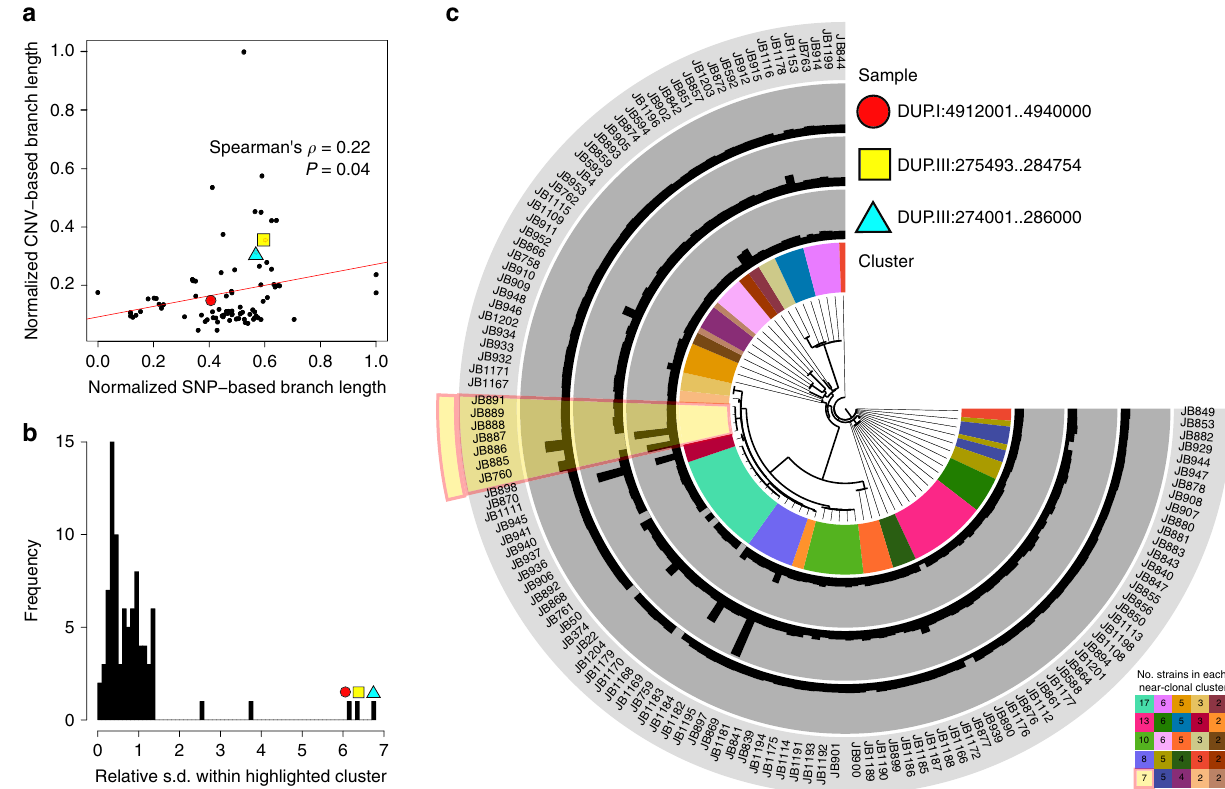
Figure 2 | CNVs are transient within fission yeast. ( a ) For each of the 87 CNVs we calculated the genetic distance between strains using SNPs in the region around the CNV (20kb up- and downstream of the CNV, merged) as the total branch length from an approximate maximum-likelihood tree ( x axis, SNP-based branch length normalized to maximum value). We further calculated a CNV-based distance using the total branch length from a neighbour-joining tree constructed from Euclidean distances between strains based on their copy numbers ( y axis, CNV-based branch length normalized to maximum value). The weak correlation indicates that CNVs are subject to additional or different evolutionary processes. ( b ) Histogram of the standard deviation of each CNV within a near-clonal cluster (see also Fig. 2a), relative to its standard deviation across strains not in the near-clonal cluster. Standard deviation is highly correlated with CNV-based branch length (Spearman rank correlation r ¼ 0.90, P o 0.001) (Supplementary Fig. 4b). The highlighted CNVs have unusually high rates of variation within this cluster compared with other clusters. ( c ) Copy number variation of these highlighted CNVs plotted on a SNP-based phylogeny (20kb up- and downstream of the DUP.III:274001..286000 CNV) shows their relative transience within the cluster, as well as their variation across other near-clonal clusters. SNP-based phylogenies for the other two selected CNVs also do not separate the strains with different copy numbers (individual plots for each CNV across clusters for its corresponding SNP-based phylogeny are available as Supplementary data).